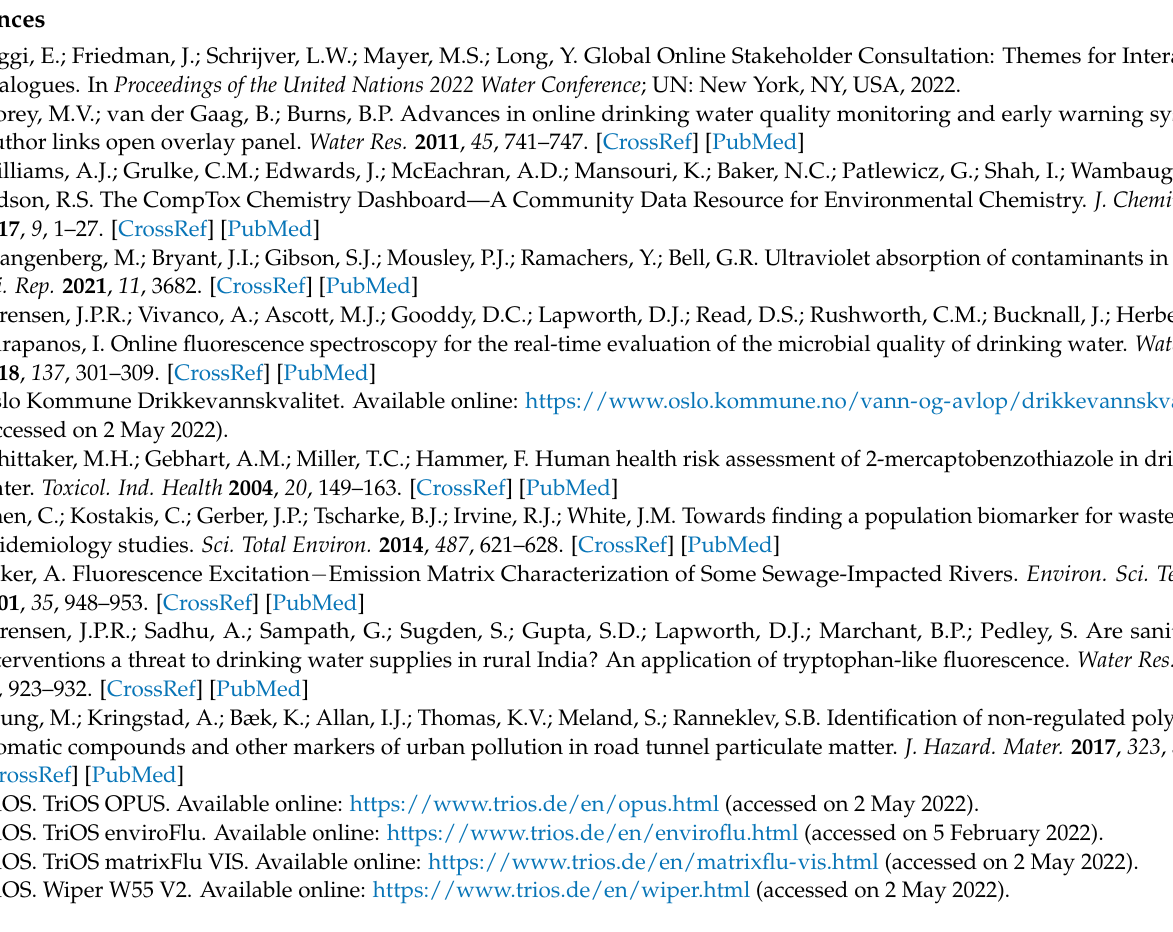
Figure A1. Absorbance as a function of time for a selected wavelength. Red denotes data with biofouling, black dashed line fitted second-order polynomial and green corrected data.